Question: In a single sentence, describe what this figure presents.
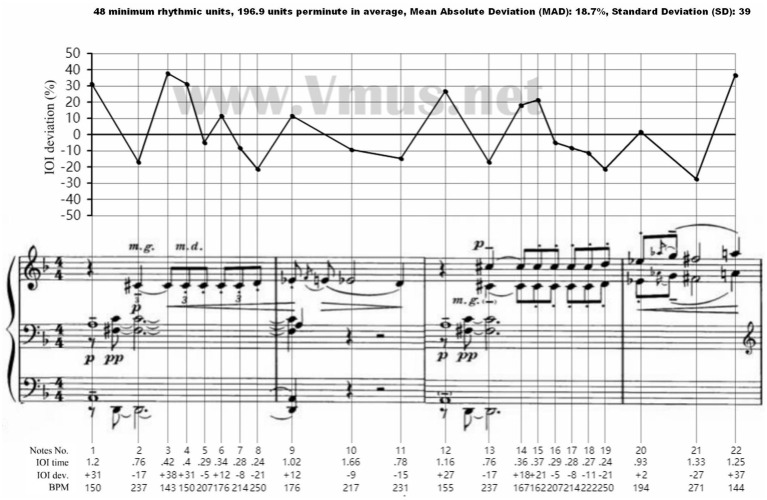
Answer: Maurizio Pollini “Viewing one of the jars” theme IOI deviation curve.